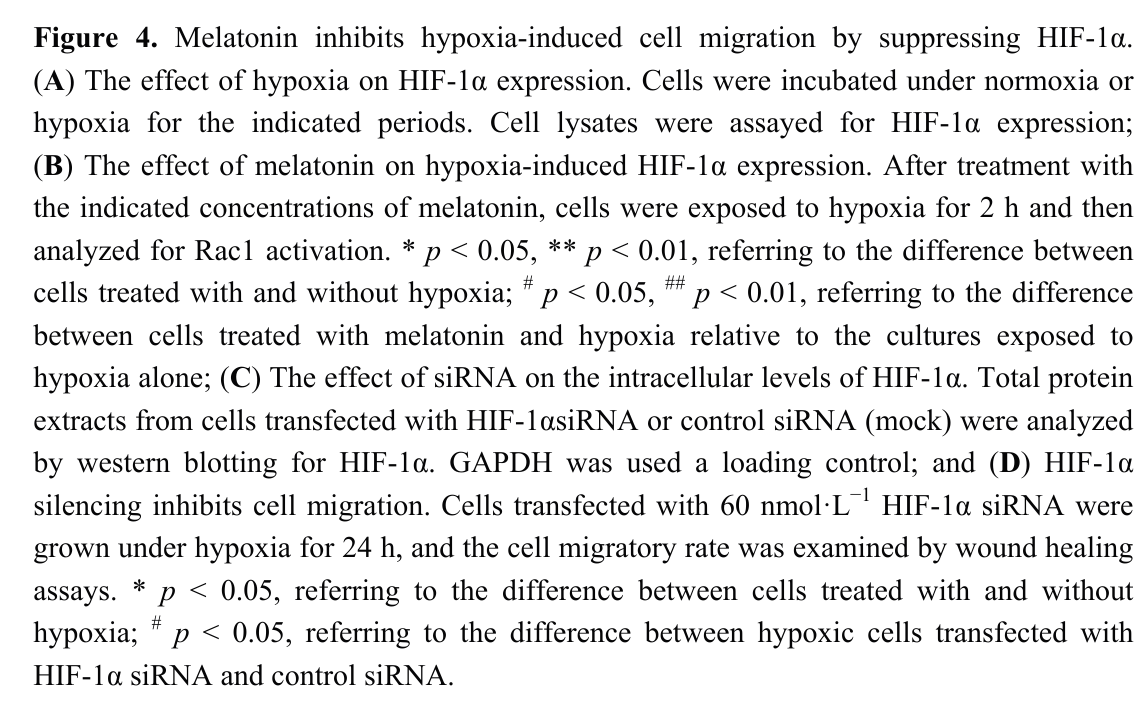
Figure 4. Melatonin inhibits hypoxia-induced cell migration by suppressing HIF-1 α . ( A ) The effect of hypoxia on HIF-1 α expression. Cells were incubated under normoxia